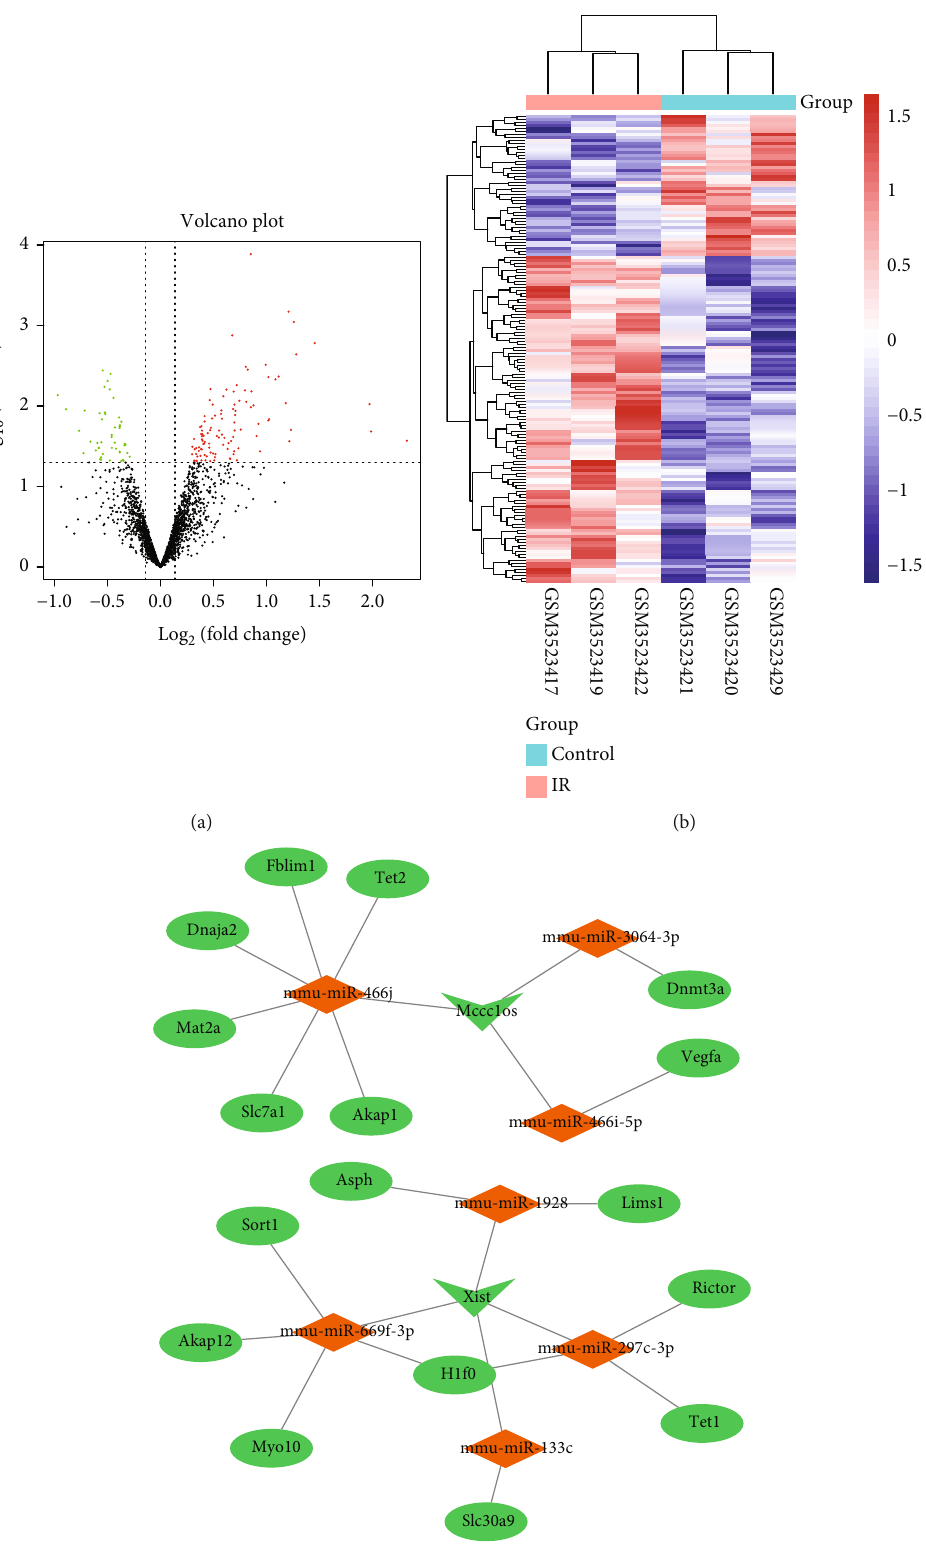
Figure 4: Construction of ceRNA network. (a, b) Volcano plot (a) and heat map (b) of DE-miRNAs between MI/R and normal group in dataset GSE124176. (c) The ceRNA network. In the network, the diamond indicates miRNA, the arrow indicates lncRNA, the oval indicates mRNA, the red means upregulation, and the green means